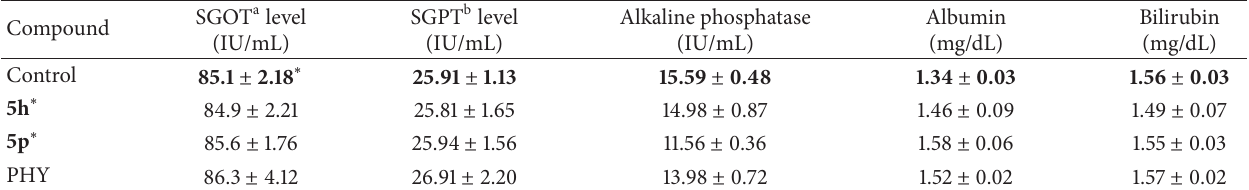
Table 6: Enzyme estimation of the selected compounds.